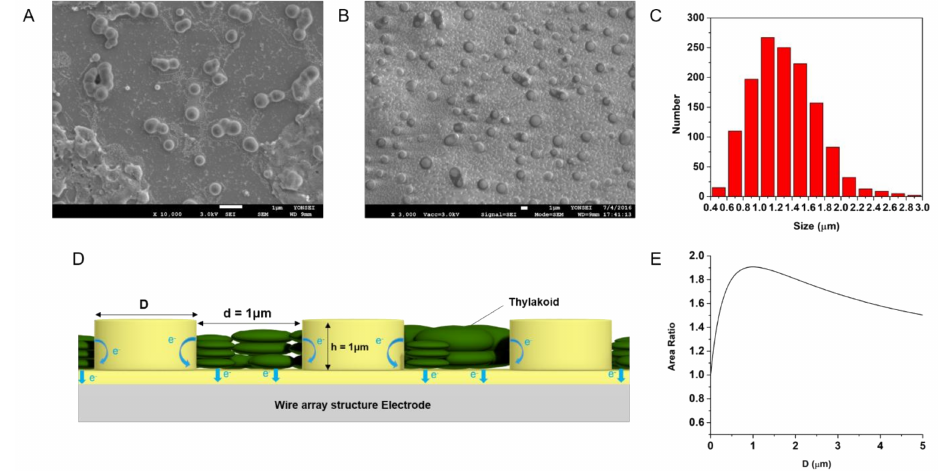
Figure 3. SEM images of ( A ) thylakoids that formed multiple vesicles and grana stack; and ( B ) single vesicle thylakoids by diluted isolation; ( C ) Histogram of thylakoid size distribution; ( D ) Schematic design of pillar-structured electrode; ( E ) Plot of the area ratio of an electrode surface with 1 µ m gap for varying pillar diameter D compared to a flat